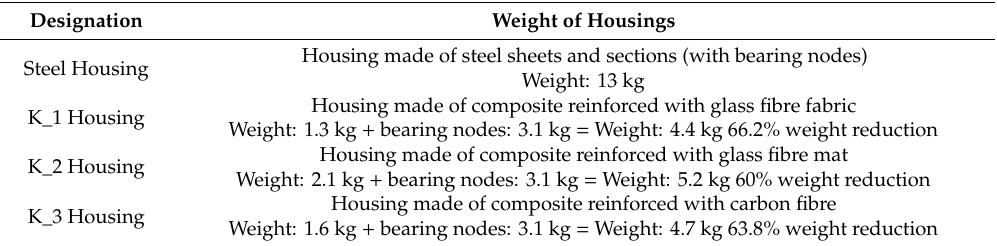
Figure 3. Bearing nodes: ( a ) before mounting, ( b ) K_3 housing with bearing nodes prepared for gluing, ( c ) and ( d ) fitting and sti ff ening of the K_1 housing during the process of gluing bearing nodes. After gluing the bearing nodes into the composite housings, their weight increased respectively to a value of: K_1 = 4.4 kg, K_2 = 5.2 kg, and K_3 = 4.7 kg (Table 2). However, the weight of composite housings is still at least 60% lower than that of the steel housing. Table 2. Weight of upper gearbox housings with glued-in bearing